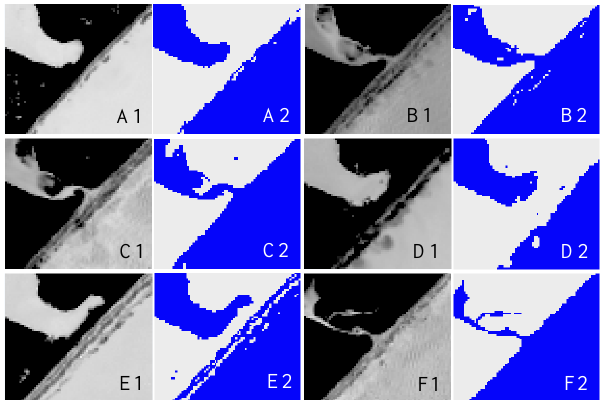
Figure 7. The NDWI (1) and cluster map (2) images for each analyzed date (A-F).